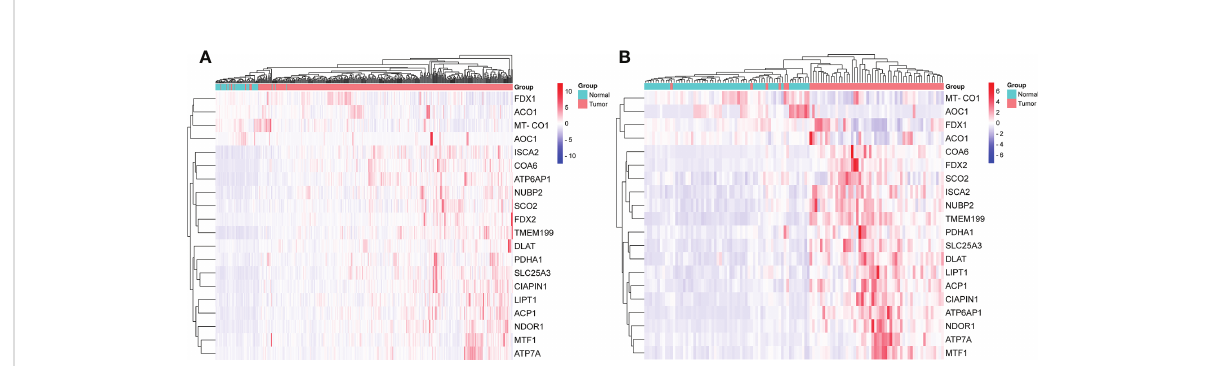
FIGURE 3 The heatmap of screened cuproptosis-related genes in normal and HCC tissues from the TCGA data. Expression levels of twenty screened cuproptosis-related genes in all samples (A) . Expression levels of twenty screened cuproptosis-related genes in 58 paired samples (B) . (ACO1, aconitase 1; ACP1, acid phosphatase 1; AOC1, amine oxidase copper containing 1; ATP6AP1, ATPase H+ transporting accessory protein 1; ATP7A, copper-transporting p-type adenosine triphosphatase 1; CIAPIN1, cytokine induced apoptosis inhibitor 1; COA6, cytochrome c oxidase assembly factor 6; DLAT, dihydrolipoamide S-acetyltransferase; FDX1, ferredoxin 1; FDX2, ferredoxin 2; HCC, hepatocellular carcinoma; ISCA2, iron-sulfur cluster assembly 2; LIPT1, lipoyltransferase 1; MT-CO1, mitochondrially encoded cytochrome c oxidase I; MTF1, metal regulatory transcription factor 1; NDOR1, NADPH dependent di fl avin oxidoreductase 1; NUBP2, nucleotide binding protein 2; PDHA1, pyruvate dehydrogenase E1 subunit alpha 1; SCO2, synthesis of cytochrome c oxidase 2; SLC25A3, solute carrier family 25 member 3; TCGA, The Cancer Genome Atlas; TMEM199, transmembrane protein